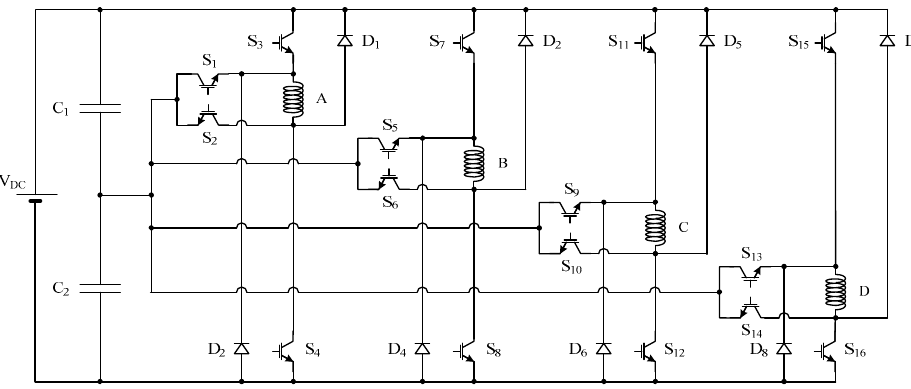
Figure 15. Multilevel converters based on classical topologies.